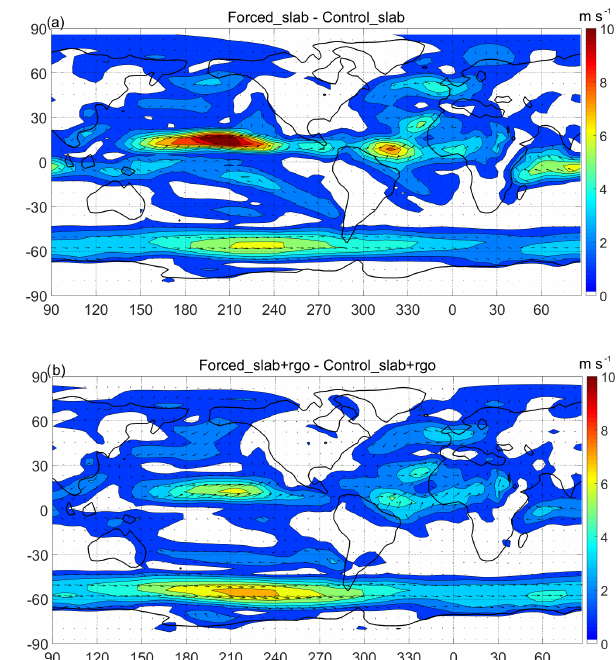
Figure 6. Annual mean anomalies with respect to the con- trol of near-surface (950hPa) wind for (a) Forced_slab and (b) Forced_slab + rgo . Contour interval 1ms − 1 .